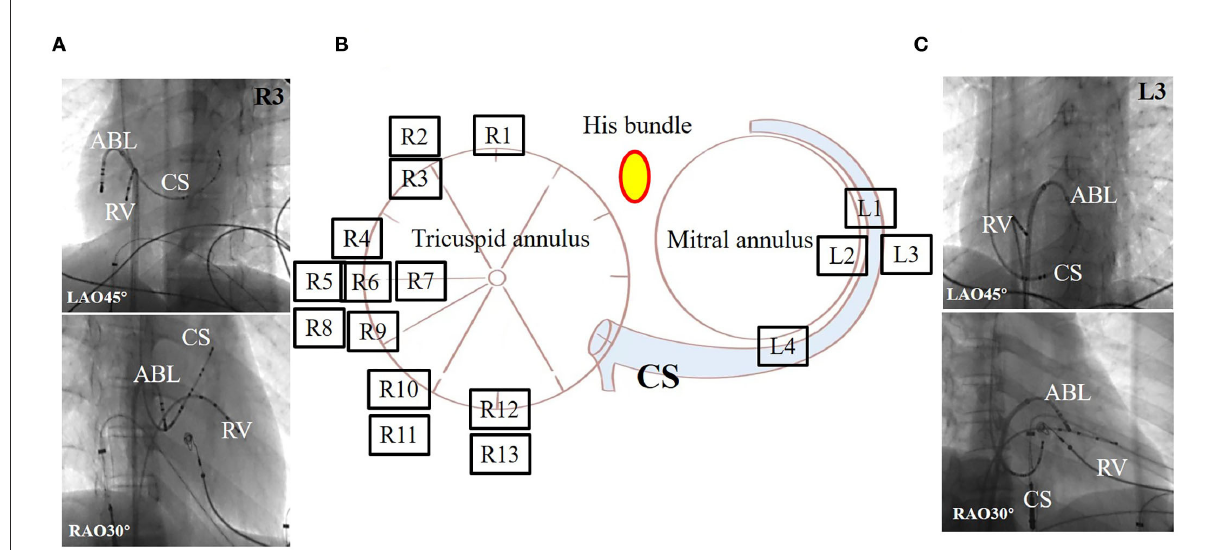
FIGURE4 Representative fluoroscopic images of successful ablation sites in two patients with Mahaim-type accessory pathway of 17 patients. (A) The fluoroscopic images in a patient with right-sided MAP. (B) Solid circles show radiofrequency ablation targets around the tricuspid and mitral annuli. There were 13 patients showing MAPs around the tricuspid annulus, but for most patients they were located at the free wall. In total, four patients had them around the mitral annulus, but in most of the patients, it was located at the free wall. The dot was represented as his bundle. (C) The fluoroscopic images in a patient with left-sided MAP. ABL, ablation catheter; CS, coronary sinus; L, patient with left-sided Mahaim; LAO, left anterior oblique; R, patient with right-sided Mahaim; RAO, right anterior oblique; RV, right ventricular.